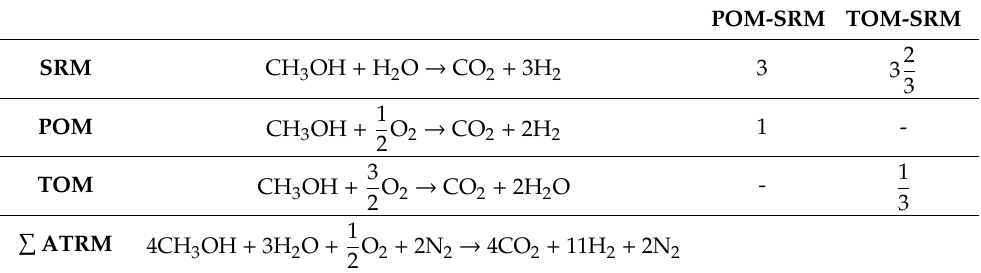
Figure 3. The possible reactions for the autothermal reforming of methanol process [24]. Table 1. The coe ffi cients of combination for two models of autothermal reforming of methanol process (ATRM)